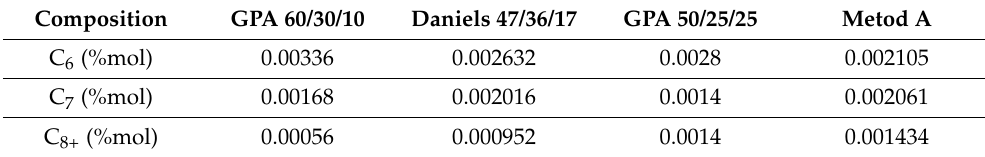
Table 4. Pendik RM-A station gas C 6 /C 7 /C 8 separated component values.